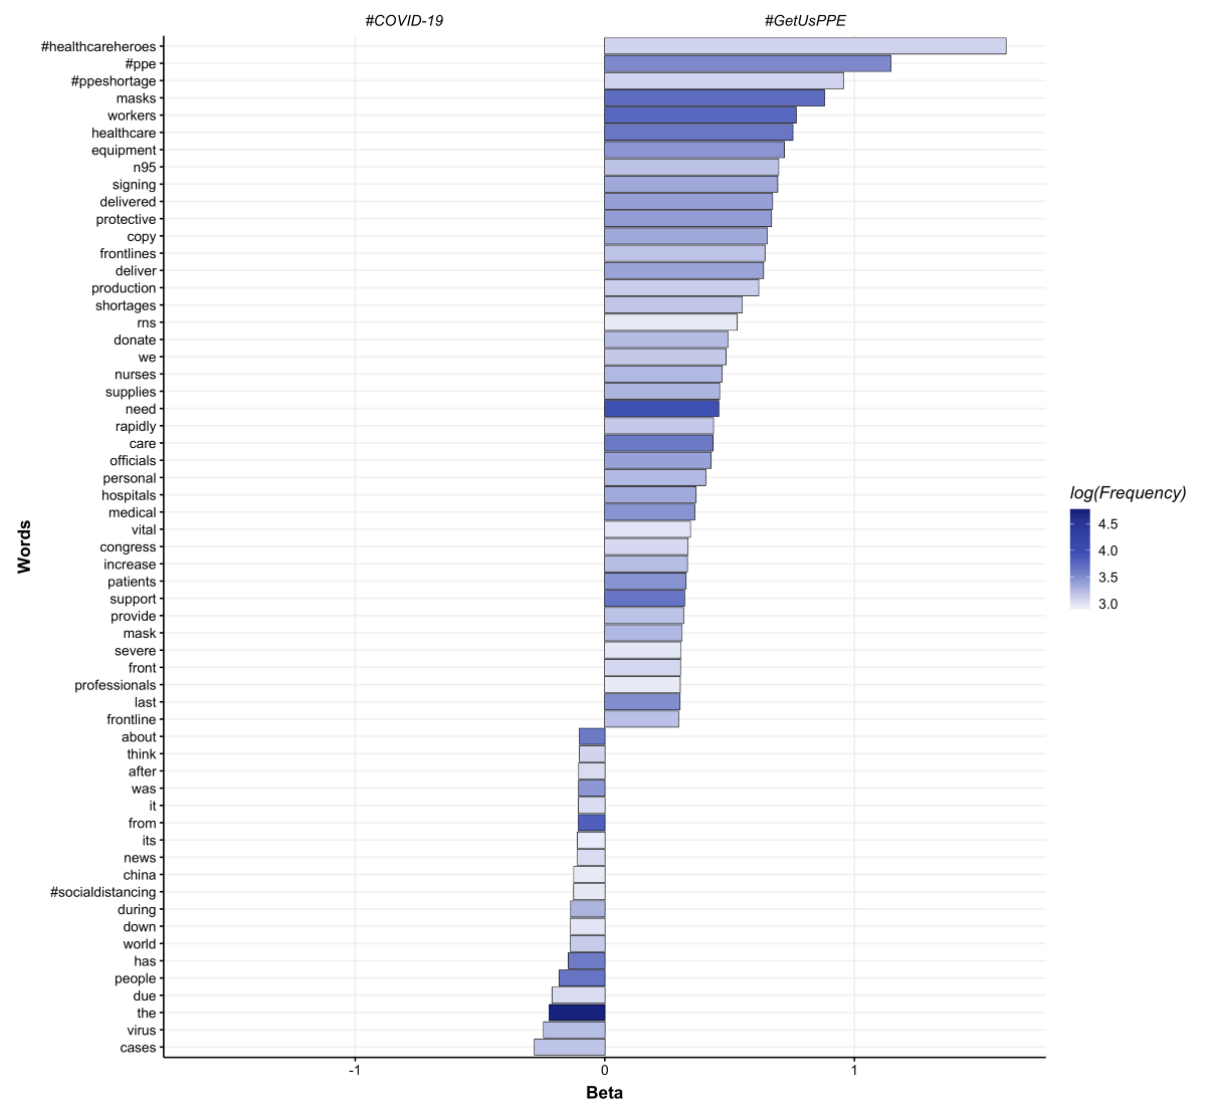
Figure 3. Words associated with #GetUsPPE tweets compared to #COVID19. Beta indicates the strength of association of each word with respective groups and color indicates frequency. All words are statistically significant at p<.05, Benjamin Hochberg